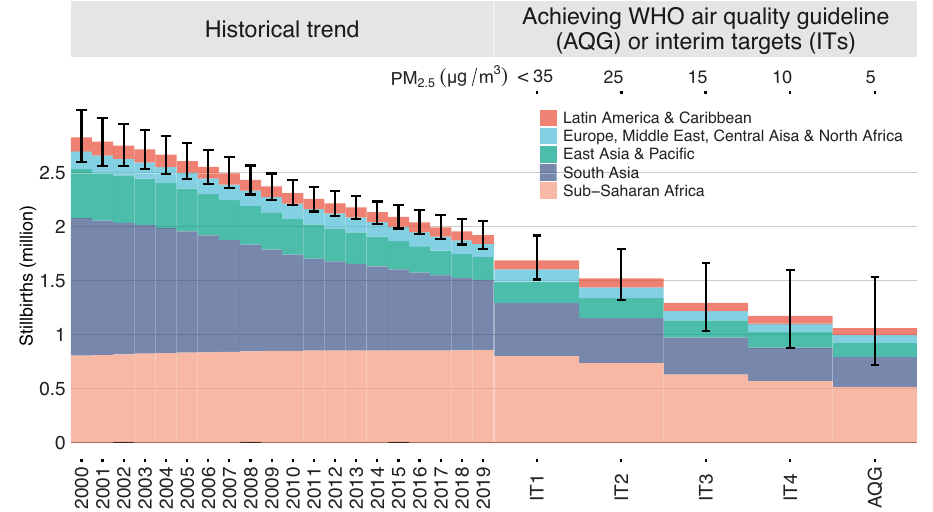
Fig. 4 | Numbers of total stillbirths and remaining stillbirths after achieving PM 2.5 targets set by the World Health Organization (WHO) among the 137 countriesfrom2000to2019. Theeffectsofachievingthetargetswereestimated